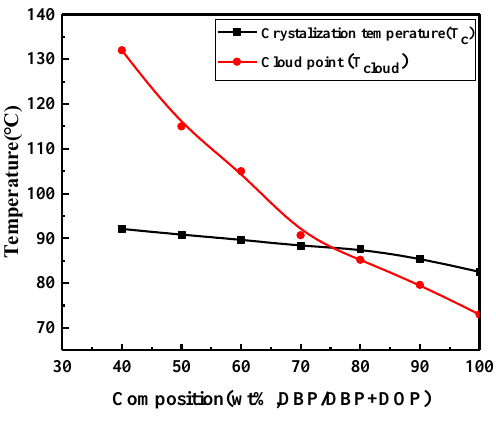
Figure 2. Phase diagram of 30 wt % PVDF-HFP membranes prepared with mixed diluent of different DBP contents.